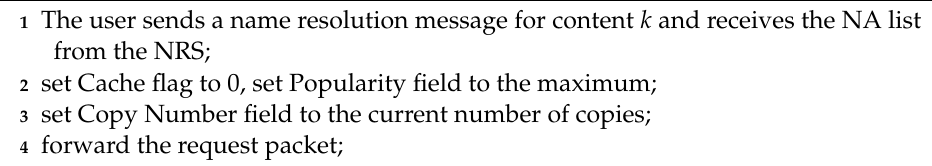
Algorithm 2: Request Packet